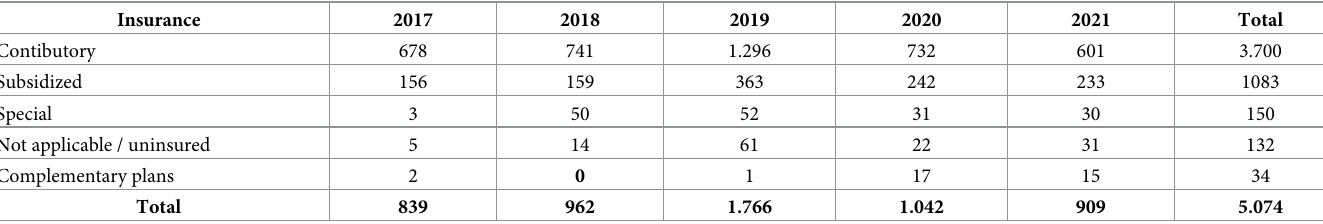
Table 3. Type of insurance of children and adolescents with sleep apnea, Colombia, 2017–2021.